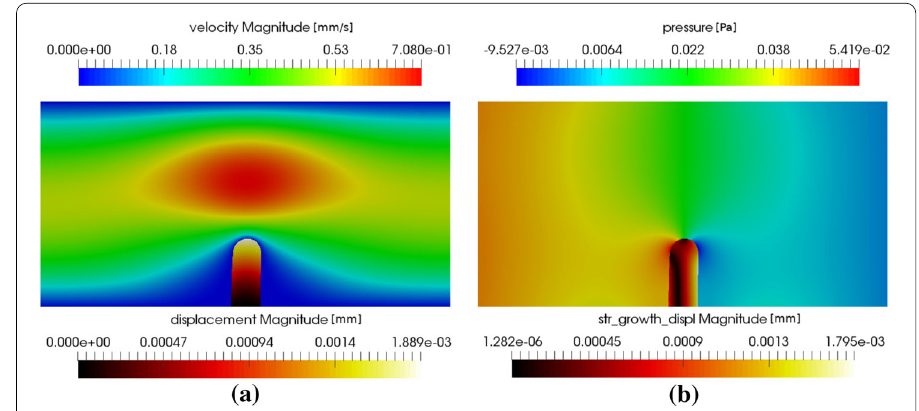
Fig. 19 Solution of the reference simulation illustrating the flow field and the deformed biofilm structure. a Fluid velocity and solid displacement field, b Fluid pressure and growth magnitude on interface as well as ALE